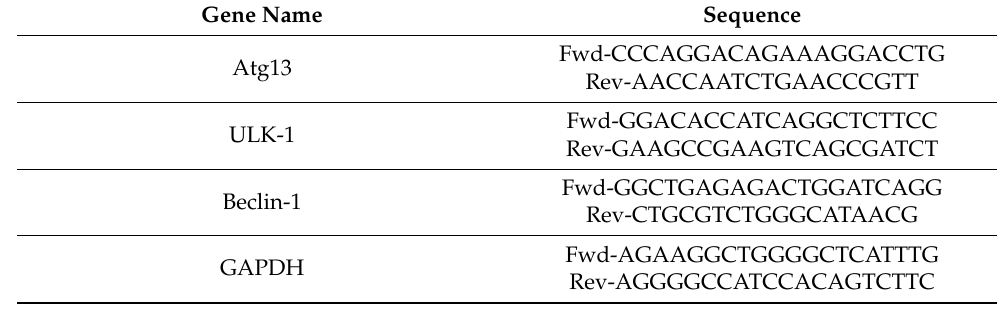
Table 1. Human-specific primer sequence used in RT-PCR studies.